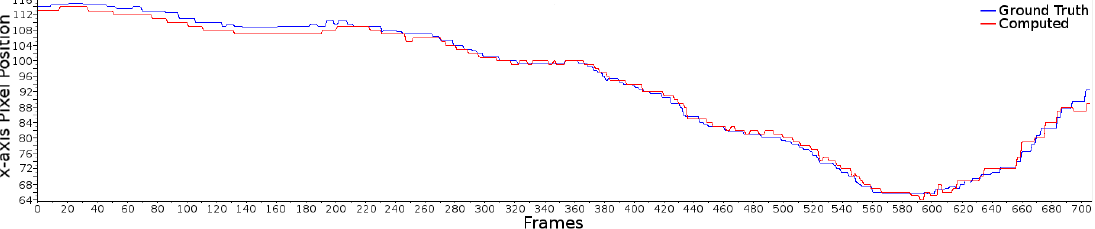
Figure 10. Centroid evaluation. The figure shows the comparison in pixels between the ground truth centroid (labeled by hand) and the estimated one. The ground truth is shown in blue while the estimated is shown in red .